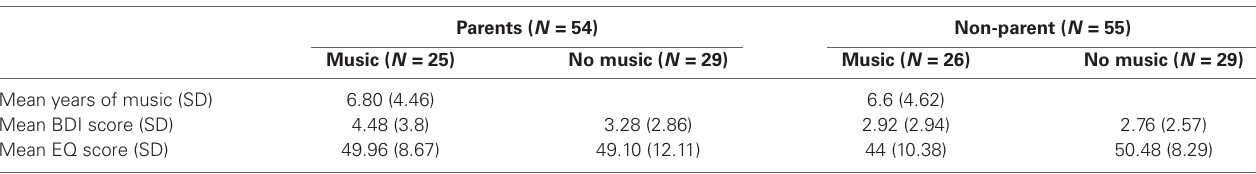
Table 1 | Participant demographic information by parental status and music